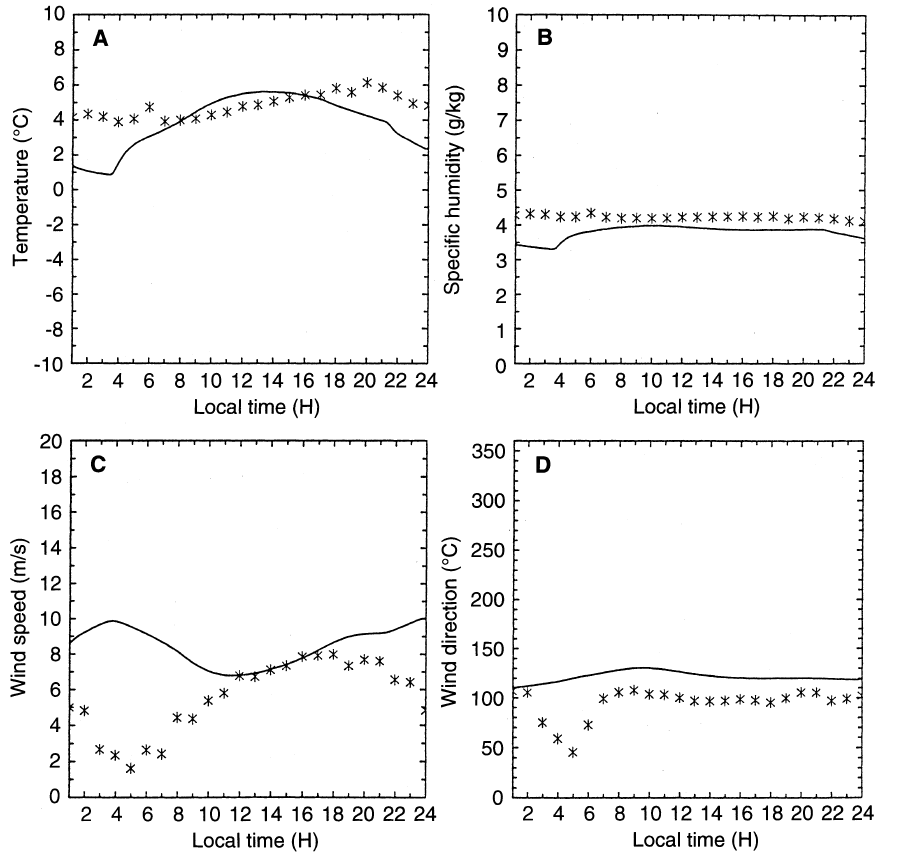
Fig. 10A–D. Time evolution of the computed and measured values of A the 2 m temperature, B the 2 m specific humidity, C the 6 m wind speed and D the 6 m wind direction on July 12 from 0000 LST to 2400 LST. The stars cor- respond to observations at